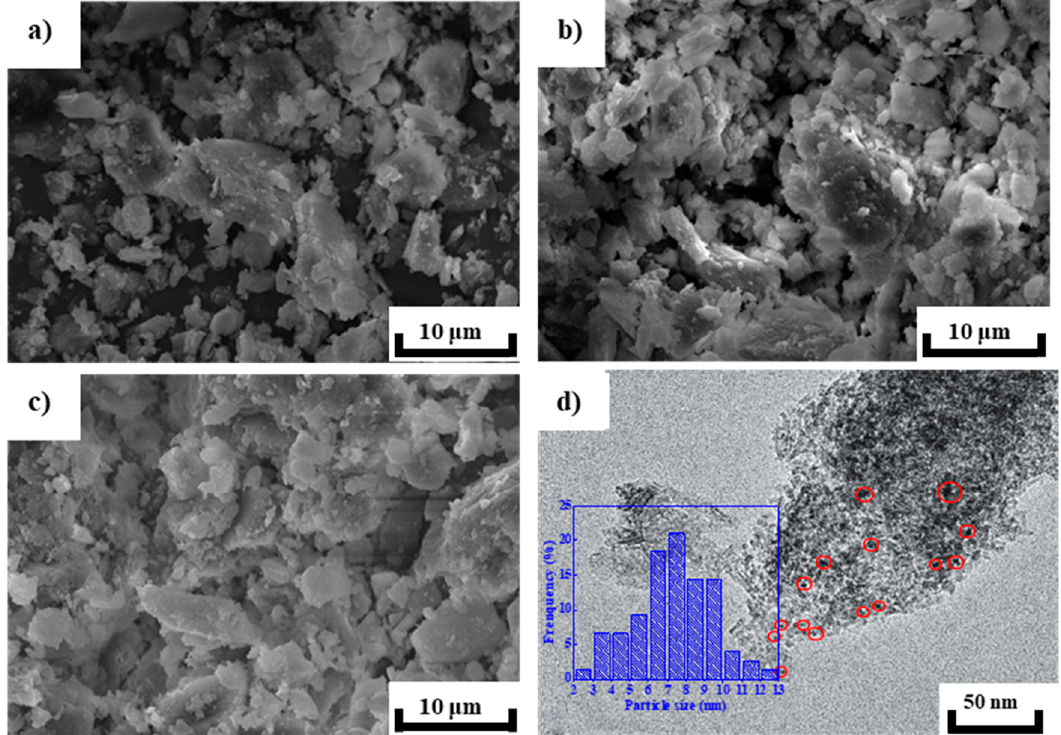
Figure 3. SEM images of ( a ) γ -Al 2 O 3 , ( b ) γ -Al 2 O 3 @ASMA, and ( c ) 5%Ru / γ -Al 2 O 3 @ASMA; ( d ) TEM image of 5%Ru / γ -Al 2 O 3 @ASMA. The insert represents the histogram of the corresponding Ru NPs size distribution in 5%Ru / γ -Al 2 O 3 @ASMA.